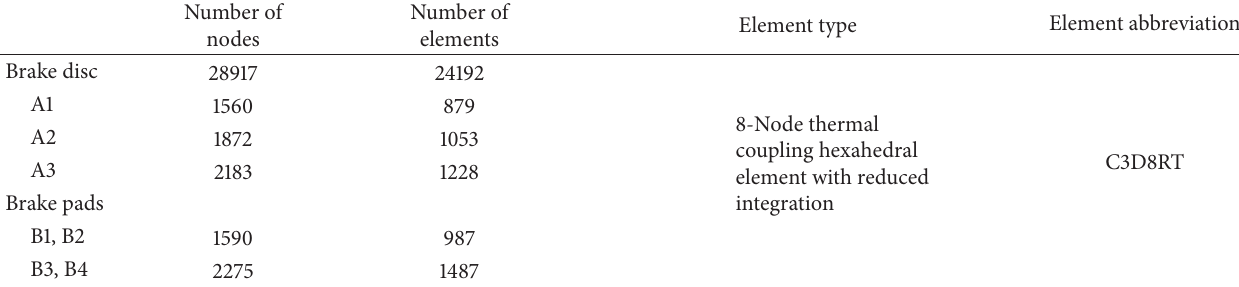
Table 3: Information on finite element mesh.